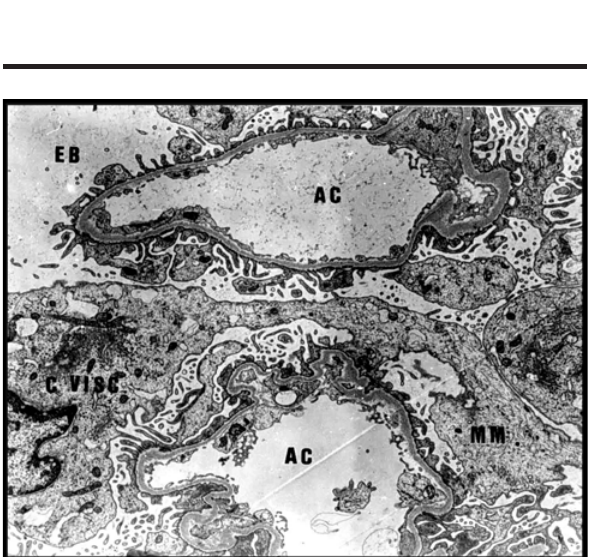
FIGURE 11 - Electronic photomicrography (15.000 X) of proximal epithelial tubular cell from GI at the time 4 (28 days), with the presence of cellular debris inside duplicated basal membrane, indicating possible repeated cycles of cellular necrosis / repair. [ DC : Cellular debris, MB : Duplicated basal